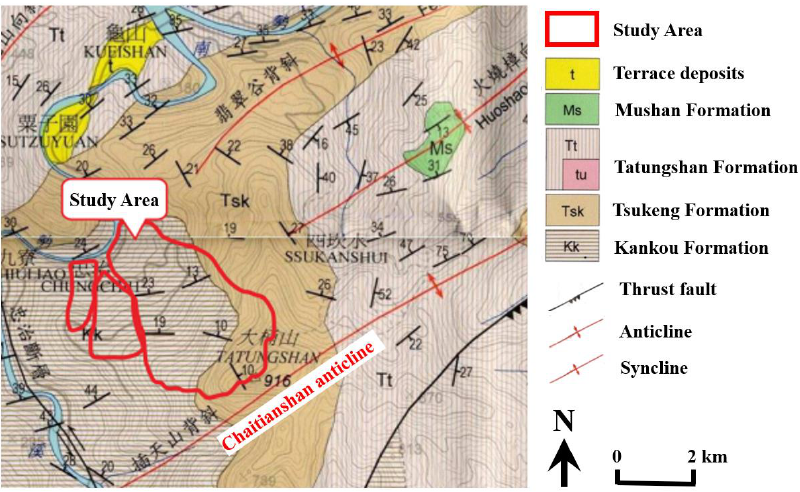
Figure 2. A 1:50,000 scale geological map of the study area.